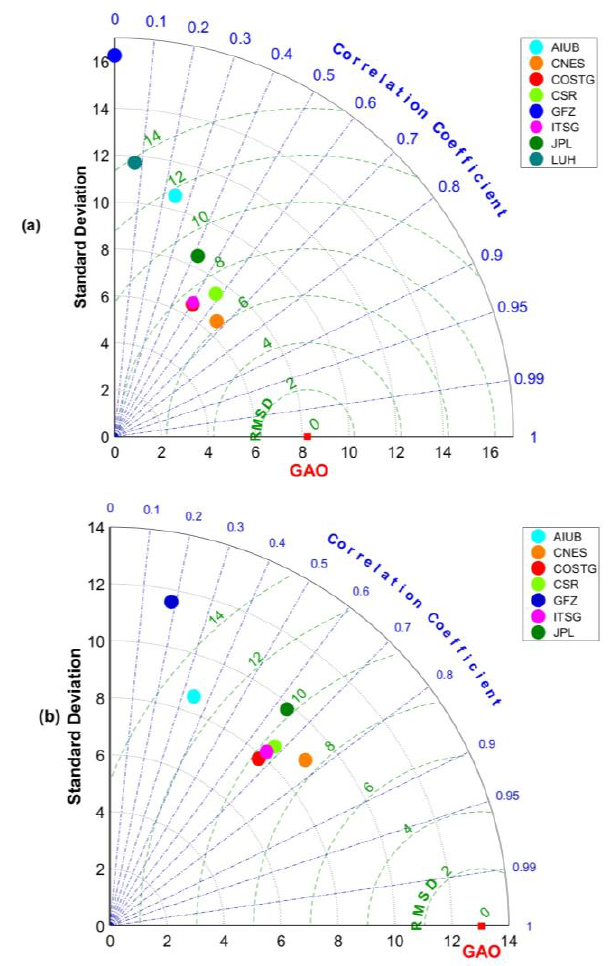
Figure 2. Taylor diagrams showing a comparison of χ 1 ( a ), and χ 2 ( b ) components of GAO (treated as a reference value), with gravimetric PM excitation determined from seven GRACE/GRACE-FO single solutions (CSR, JPL, GFZ, ITSG, CNES, AIUB, and LUH) and one combined solution (COST-G). The critical value of the correlation coefficient for 75 independent points and a 95% confidence level is 0.19, and the standard error of the difference between the two correlation coefficients is